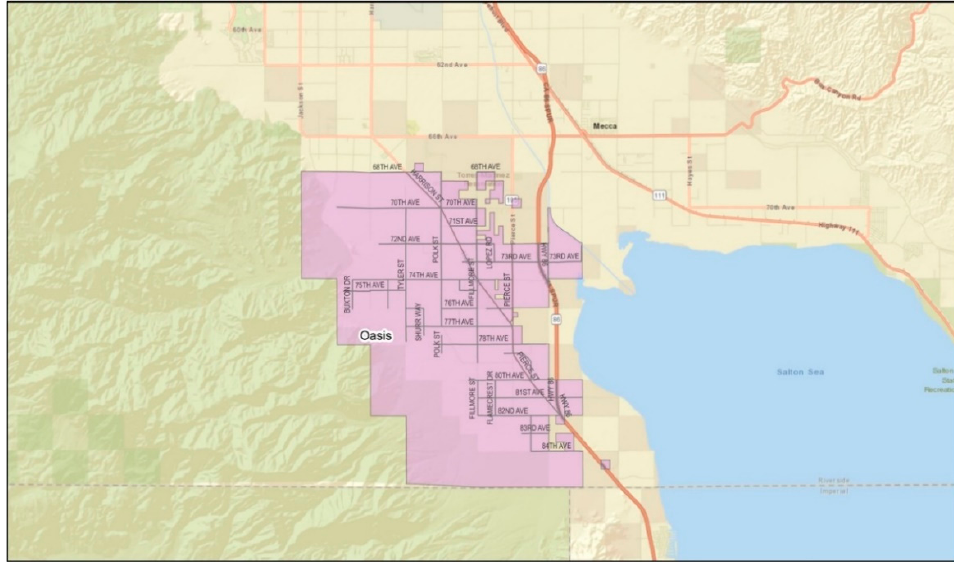
Figure 3. Geographical division of the community of Oasis. (Source: Riverside University Health System—Public Health).